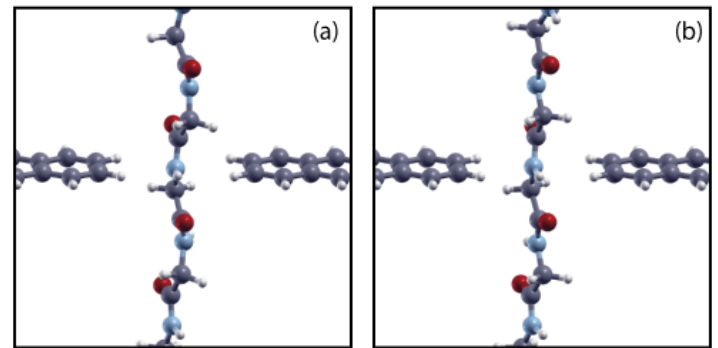
Figure 3. Example of a DFT relaxation pattern at the second stage of the protocol described in the text. Here we represent the NH 3 configuration case (see Section 3): ( a ) initial atomic positions; ( b ) final atomic